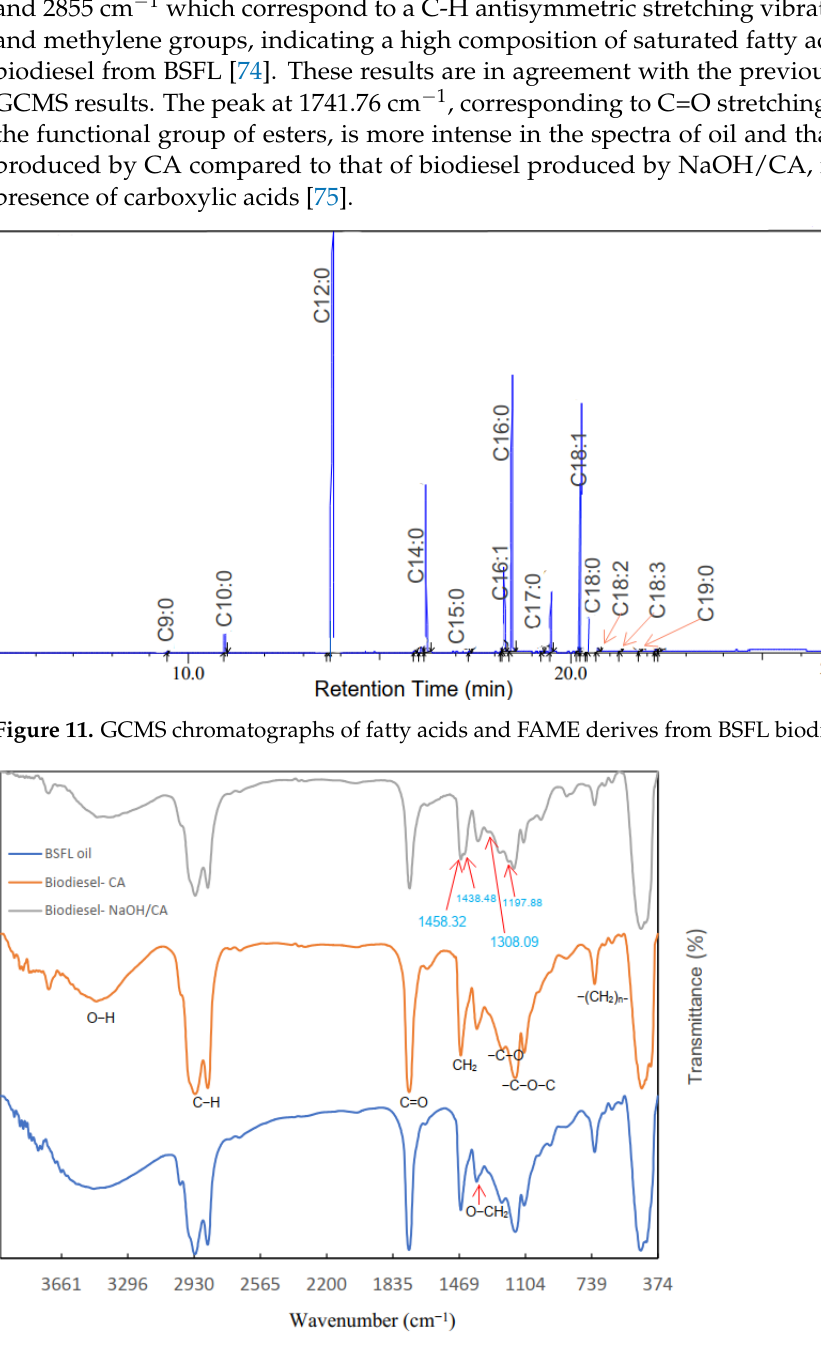
Figure 12. Comparison of FTIR spectra of BSFL-derived oil and biodiesel.